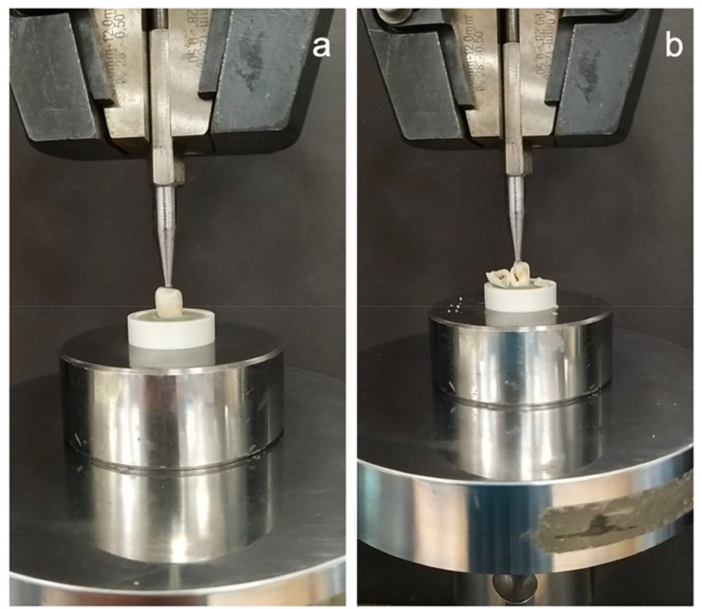
Figure 4. ( a ) The specimen was subjected to an axial compressive load meant to cause fracturing by using a 3 mm diameter steel ball that contacts the restoration at the center area at a crosshead speed of 0.5 mm/min. ( b ) Fractured specimen.